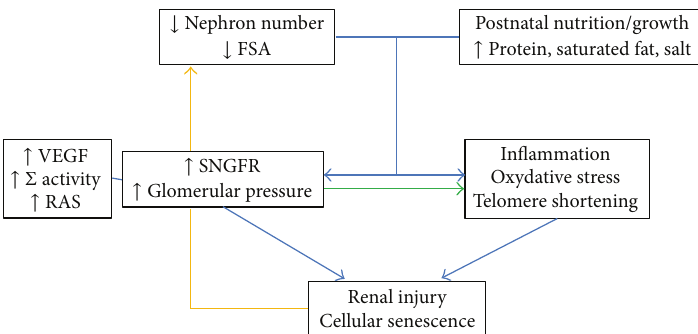
Figure 2: Proposed pathophysiological mechanism of renal injury (glomerular endothelium barrier disruption, podocyte dysfunction, interstitial fibrosis, tubular ischemia). FSA: filtration surface area; GFR: glomerular filtration rate; SNGFR: single nephron glomerular filtration rate; RAS: rennin angiotensin system; VEGF: vascular endothelial growth factor system; ∑ : sympathetic nervous system.